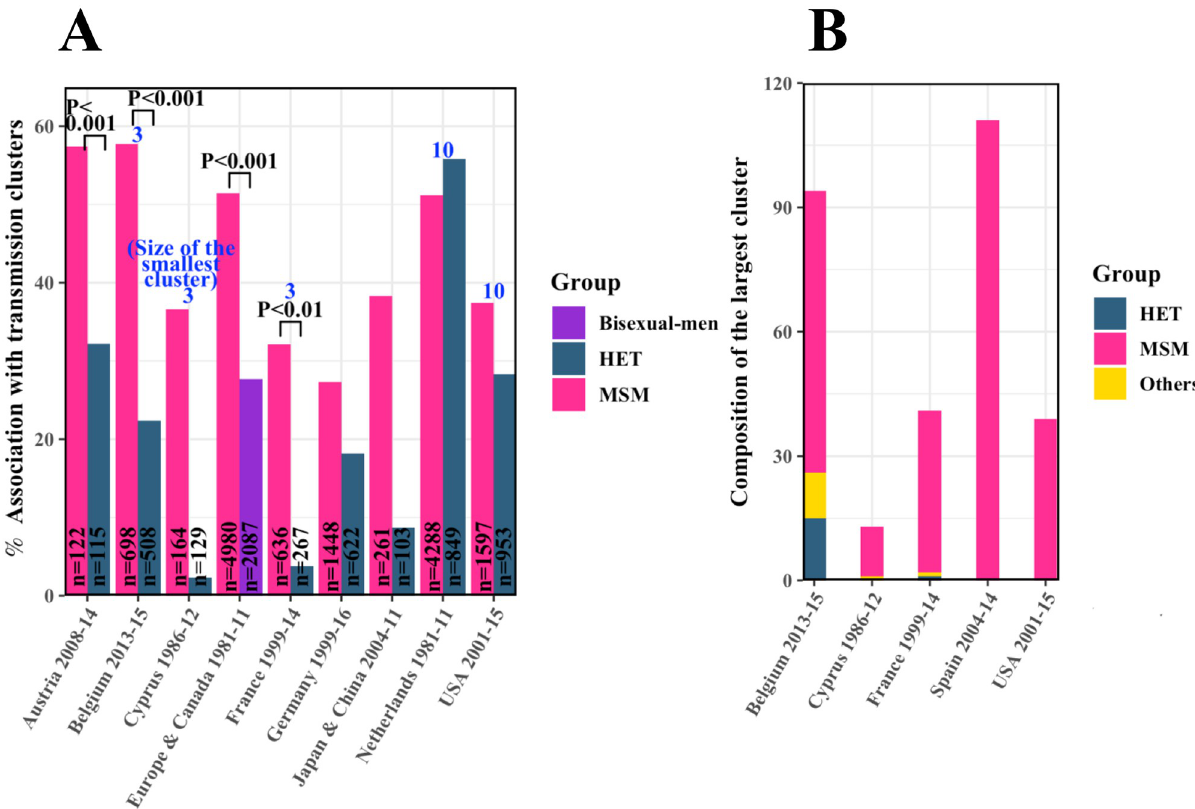
Fig 4. Association with transmission clusters. (A) The fraction of HET and MSM (or bisexuals in one case) associated with transmission clusters and (B) the size and composition of the largest clusters in different geographical regions. The sample sizes ( n ) along with the time periods of the surveys are indicated. P values and the minimum sizes of the clusters (blue text) where available from the original sources are listed (see S8 Table).